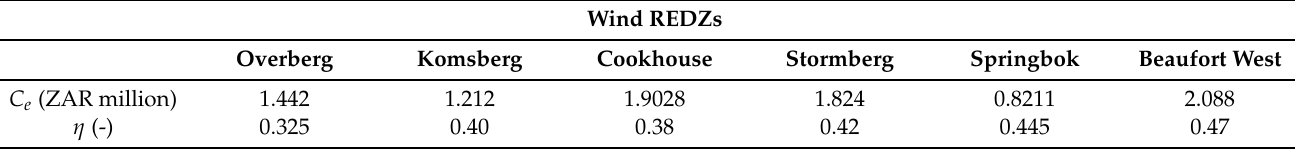
Table 13. Cost of electricity and efficiency using N43 wind turbine model for wind